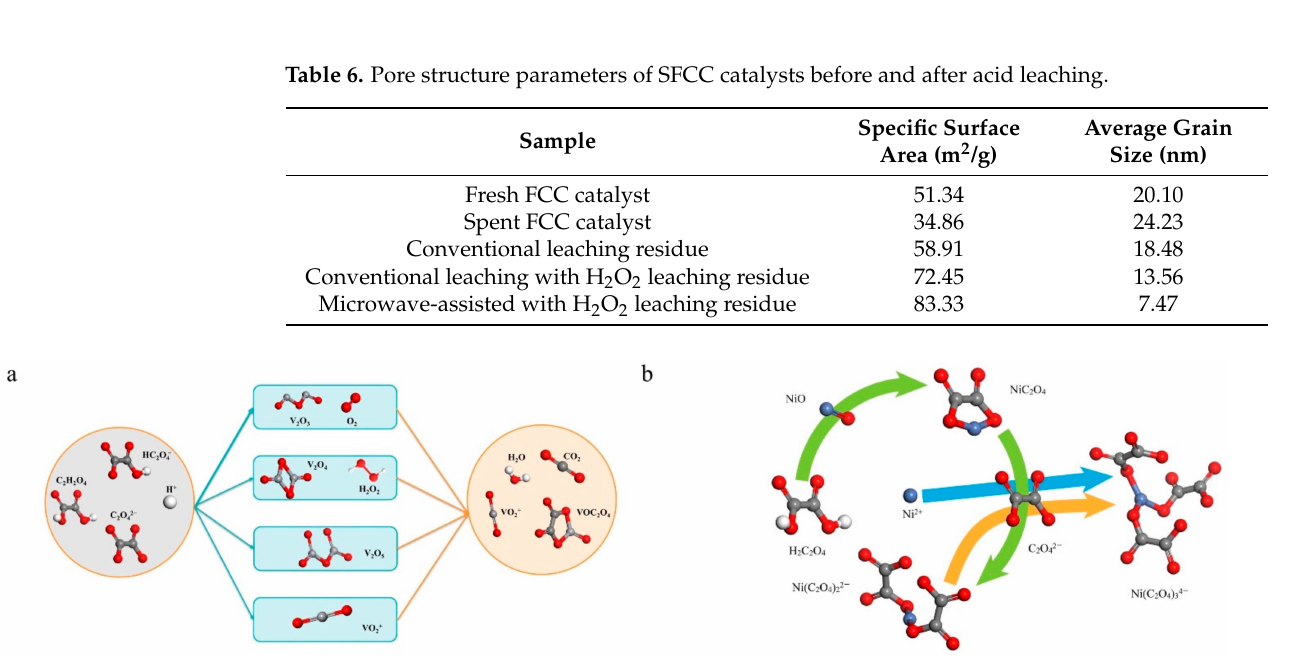
Figure 10. Extraction mechanism of V and Ni in SFCC catalyst by oxalic acid under microwave- assisted conditions (( a ). Extraction mechanism of V; ( b ). Extraction mechanism of